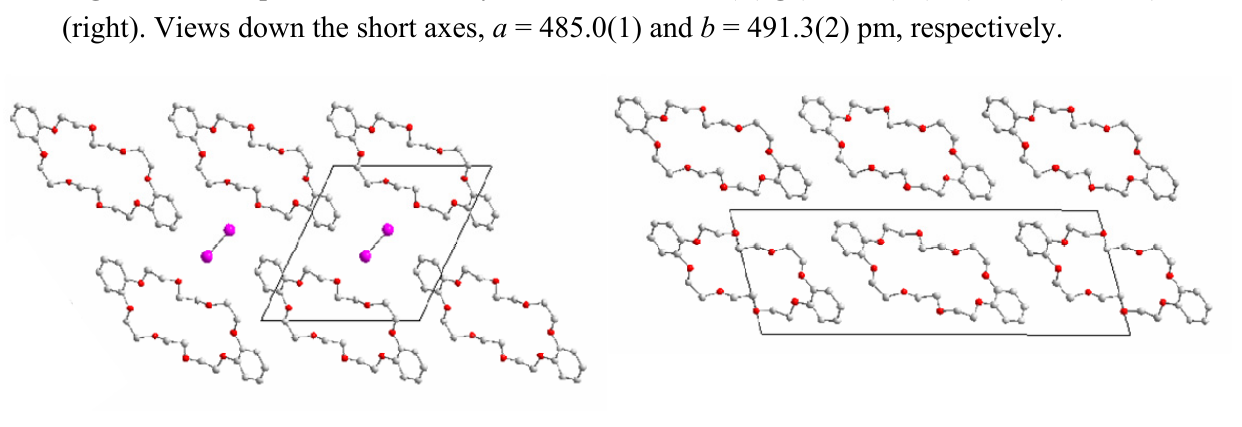
)@(db24c8) (left) and (db24c8) 2